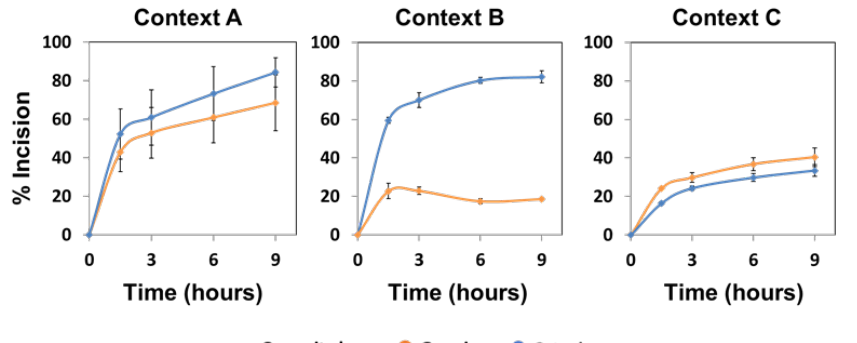
Figure 6. Effect of sequence context and base opposite the abasic site on the AP lyase activity of native FPG. Cell extracts from arp −/− plants (25 μg) were incubated at 37 °C with 20 nM DNA sub- strates (contexts A, B or C) containing an AP site opposite guanine (orange) or cytosine (blue). After stabilization with NaBH 4 , the reaction products were separated by denaturing PAGE, detected by fluorescence scanning and quantified. Data are the mean and standard error from three independent experiments.